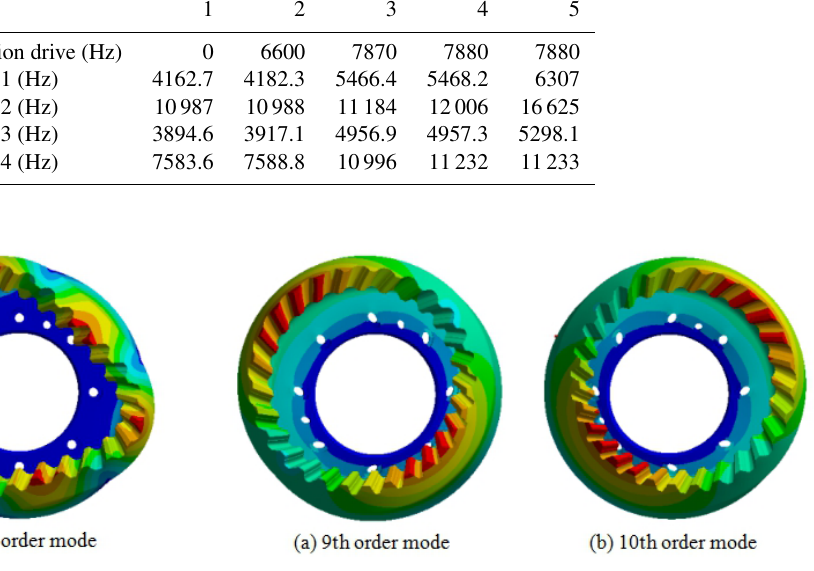
Figure 12. The 7th and 8th order modes of bevel gear 1: bending vibration.